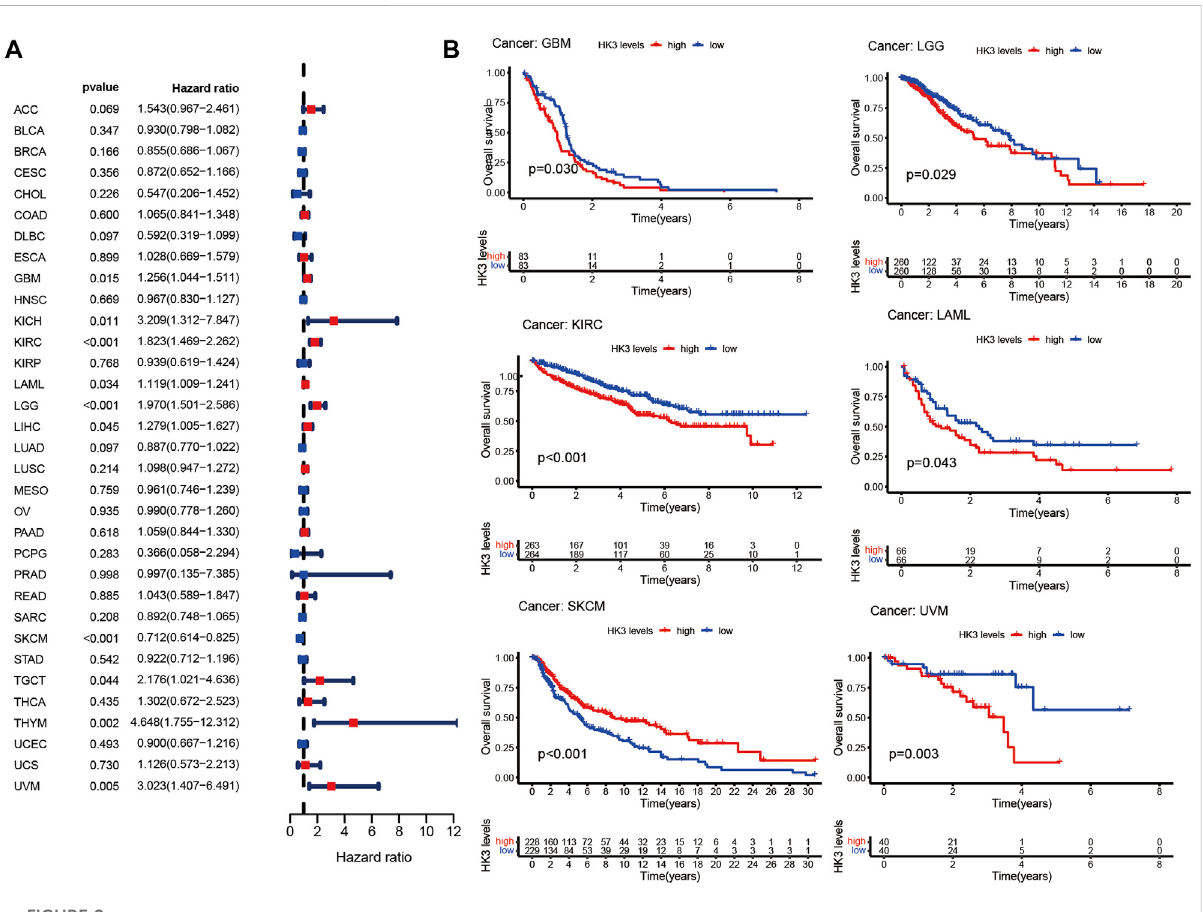
FIGURE 2 HK3 expression in 33 different types of tumors in the TCGA database and OS. (A) Forest plots of univariate Cox regression analysis; (B) Kaplan- Meier survival